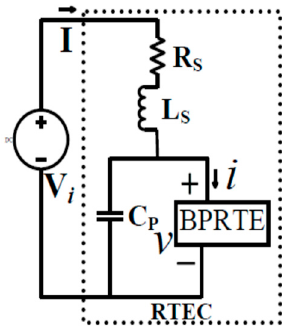
Figure 1. Scheme of basic resonant tunneling electronic circuit (RTEC) unit [1].